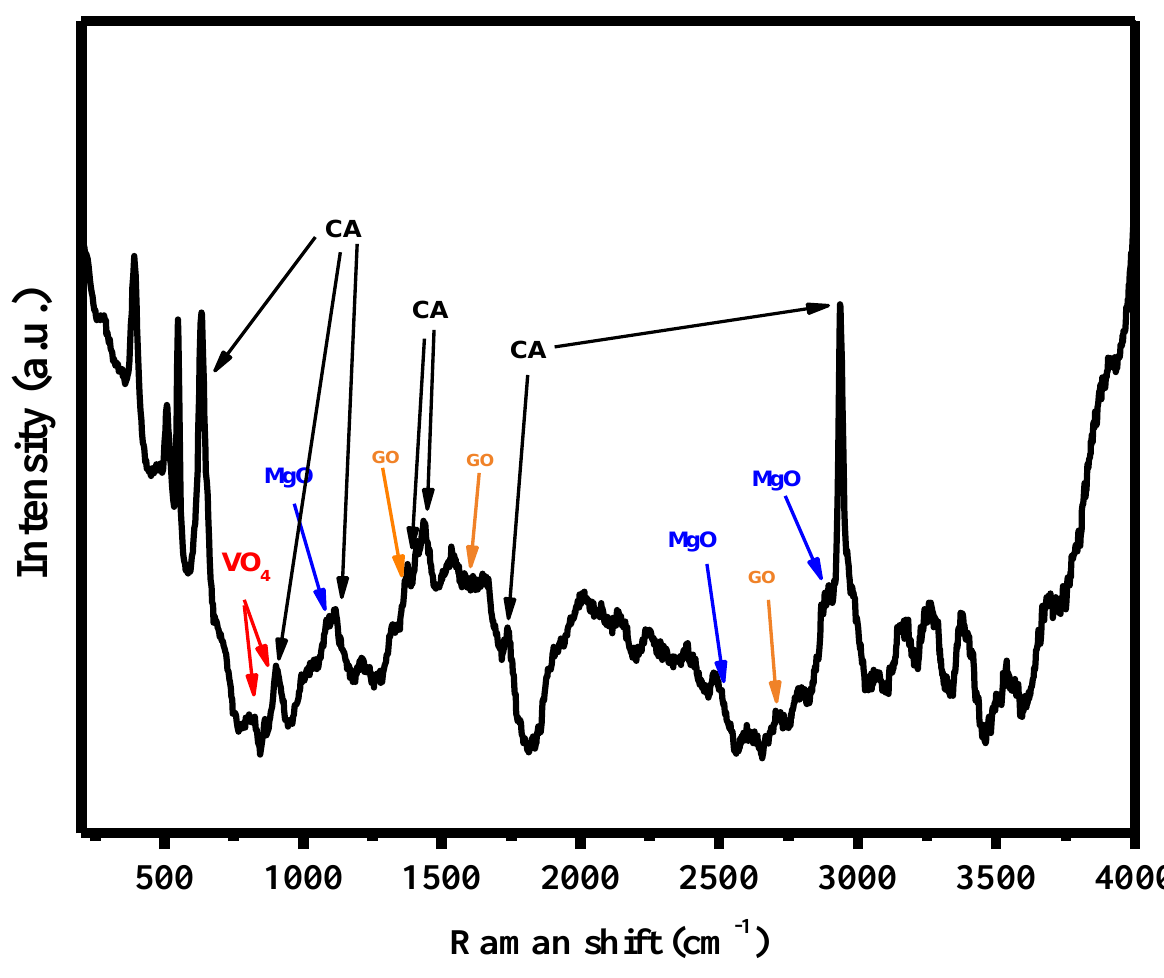
Figure 9. the Raman shift for Mg 3 (VO 4 ) 2 /MgO/GO@CA . Figure 9. The Raman shift for Mg 3 (VO 4 ) 2